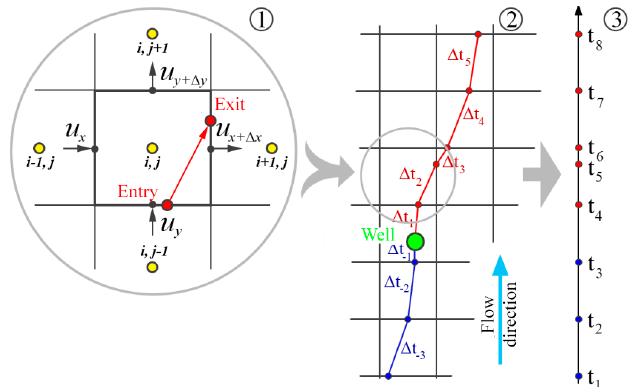
Figure 7. (1) Streamline calculation according to Pollock’s method; (2) streamline calculation down- stream and upstream from well; (3) upstream and downstream streamlines merging.